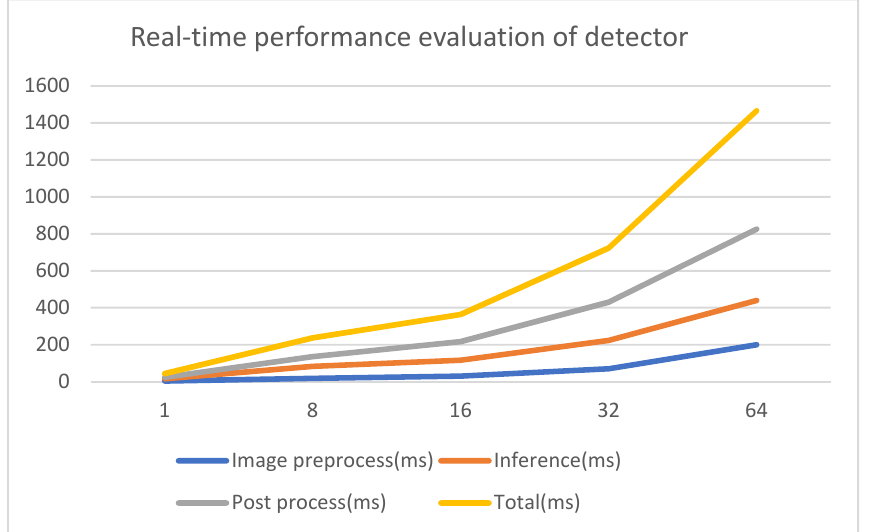
Figure 2. The detector with different batch size (X-axis represents batch size, Y-axis represents time consumption). Blue line indicates image preprocessing, it is related to the operation of the original frame resize; brown line indicates model inferencing for image data; gray line indicates processing of model inference results, including NMSs (nonmaximum suppression); yellow line indicates time consumption of detector.